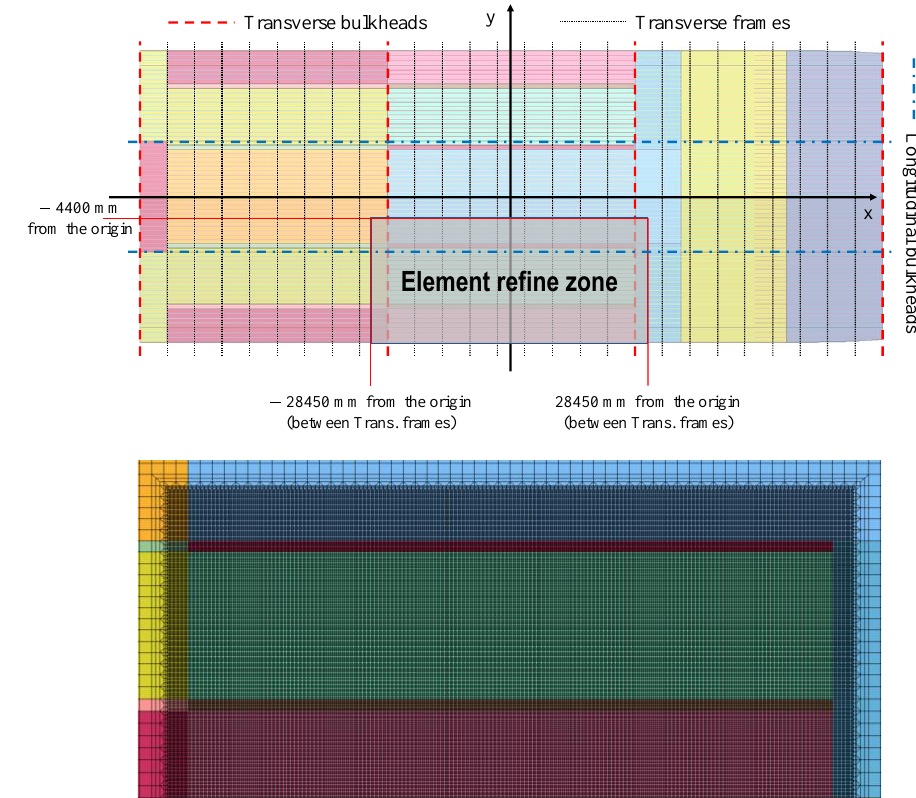
Figure 3. Element refine zone (upper) and refined elements (lower) (top view).